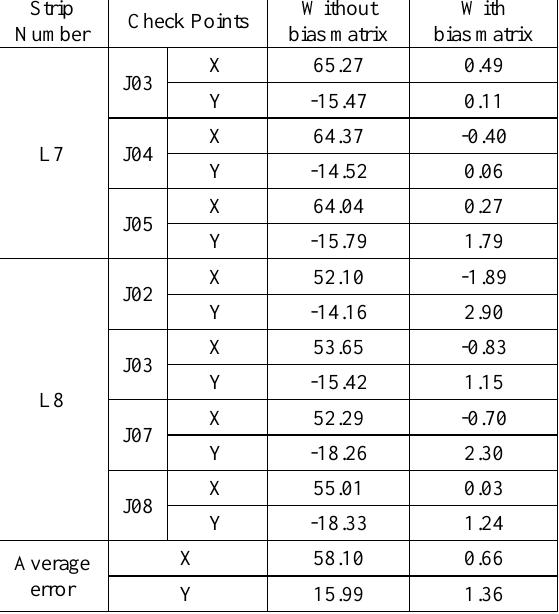
Table 1. Evaluation results (Unit: